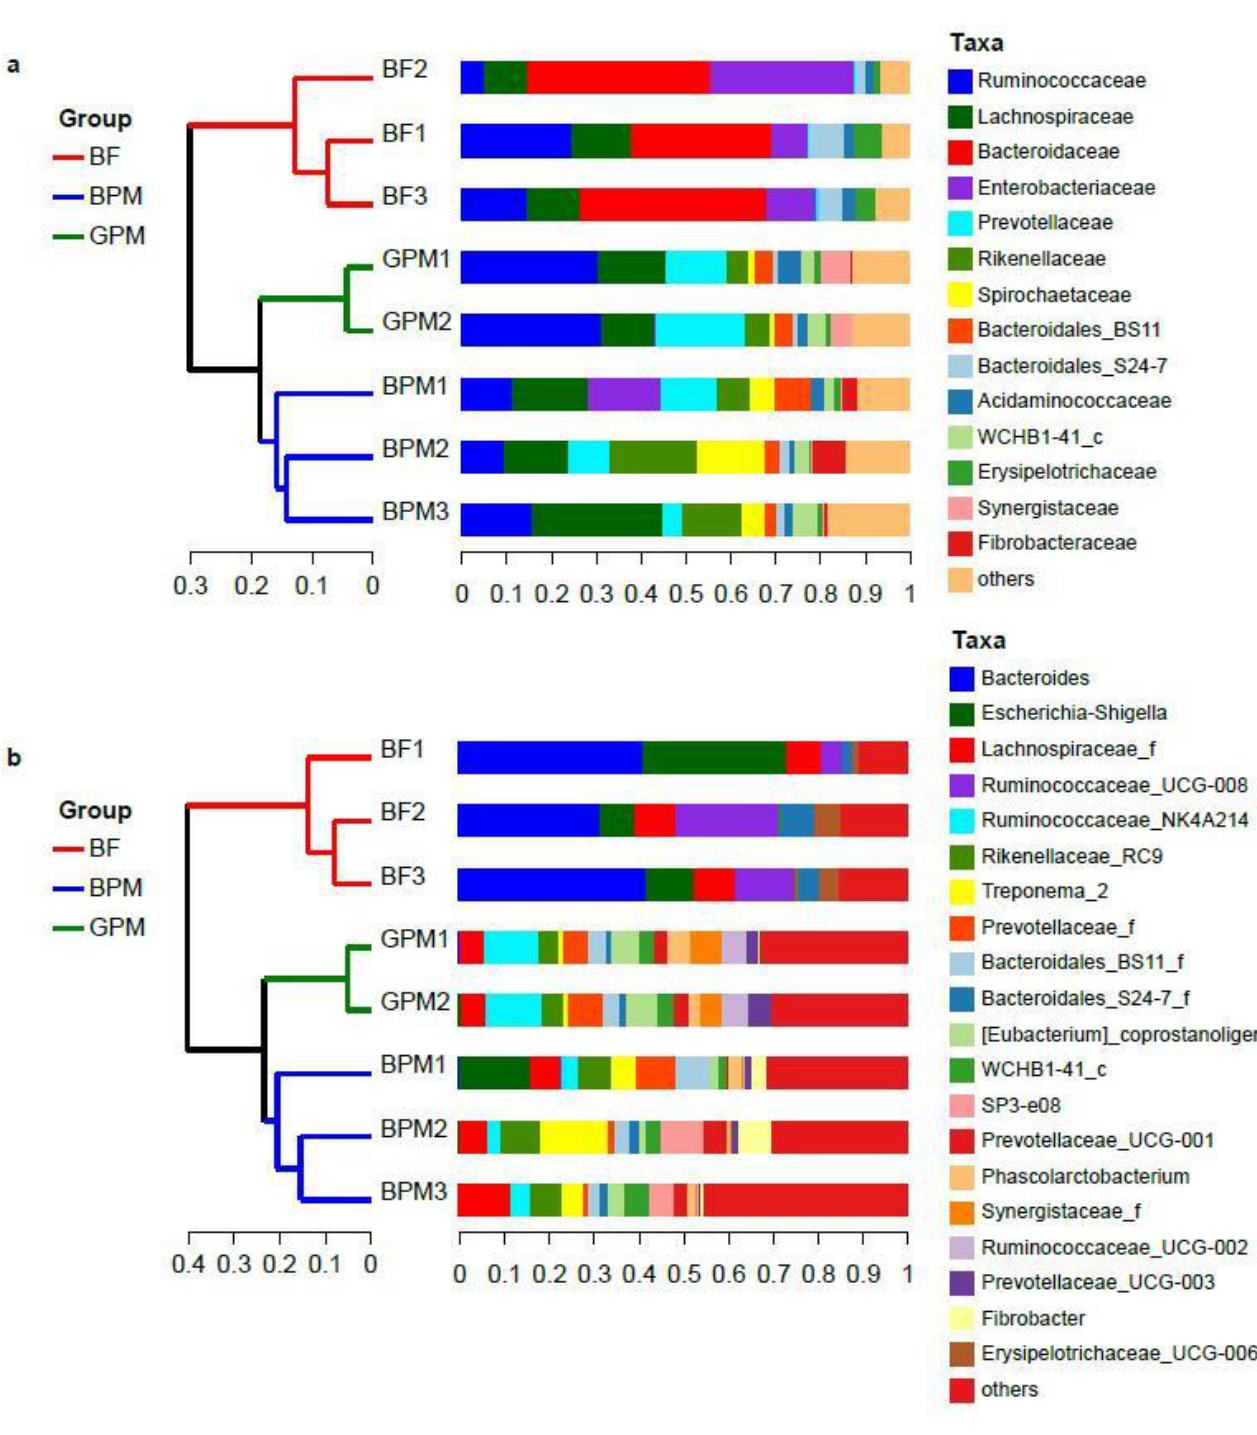
Figure 1. ( a ) Hierarchical clustering tree of species at the family level obtained from samples based on the unweighted pair group method with arithmetic mean (UPGMA) clustering analysis method; ( b ) species-level hierarchical clustering trees at the genus level obtained from samples based on the UPGMA cluster analysis method. BF1, BF2, and BF2 refer to the elephant milk-only diet group, BPM1, BPM2, and BPM3 refer to the elephant milk–plant mixed-feed diet group, and GPM1 and GPM2 refer to the goat milk–plant mixed-feed diet